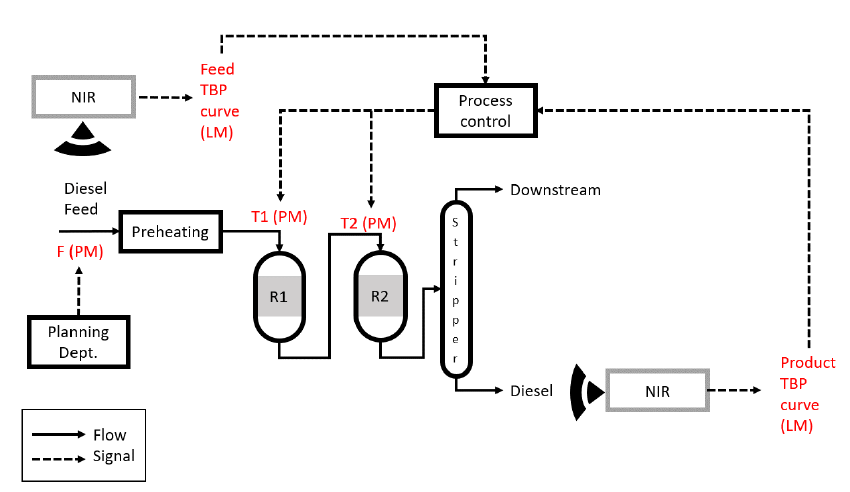
Figure 13. Hydrocracker flowchart with altered signals to realize